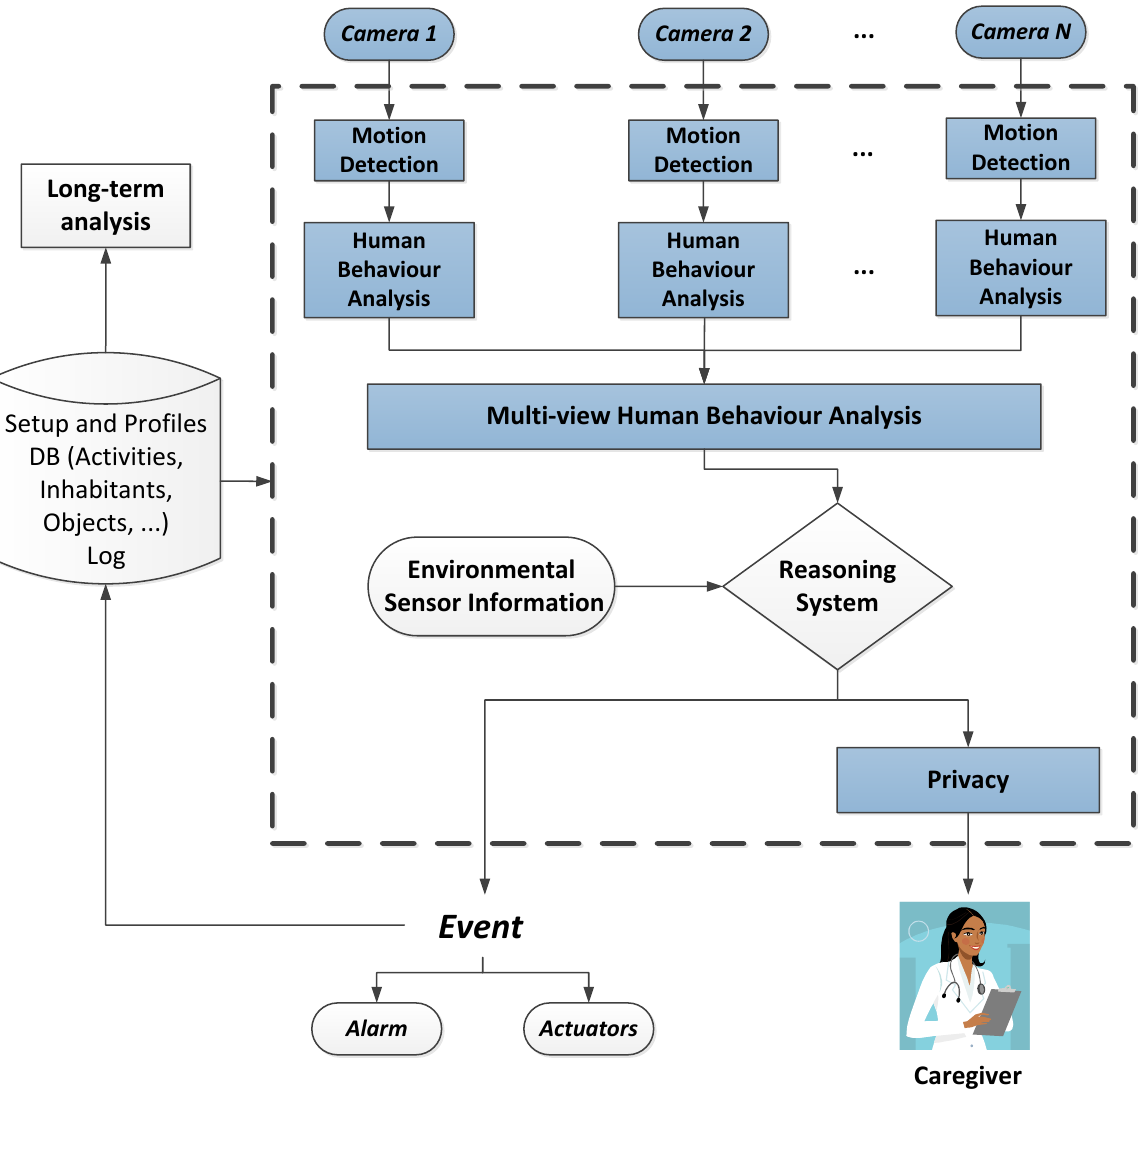
Figure 1. Architecture of the intelligent monitoring system to promote independent living at home and to support AAL services. The parts that are further specified in this contribution are shaded in blue. (DB stands for